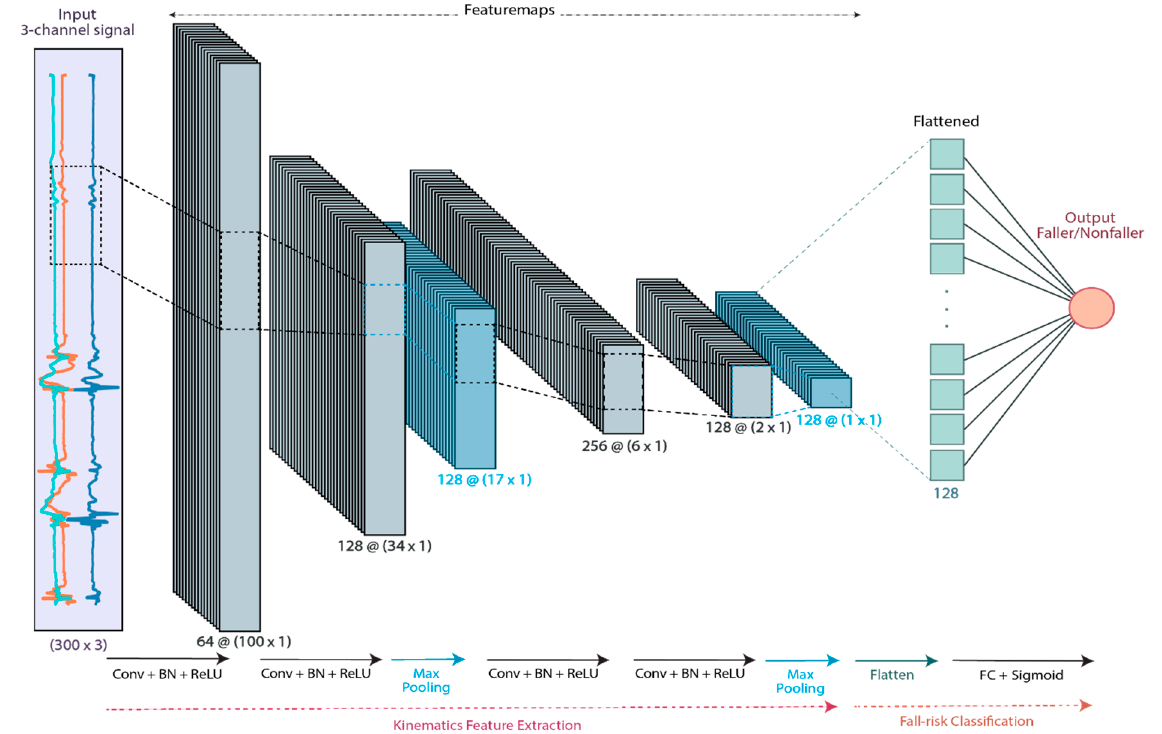
Figure 3. The CNN architecture of the proposed fall-risk classification model. The 3-channel acceleration or angular velocity 3 s segments are fed into the convolutional building blocks, and the high-level kinematics feature map is extracted. The features are flattened and classified as faller/non-faller by a fully connected neural network.